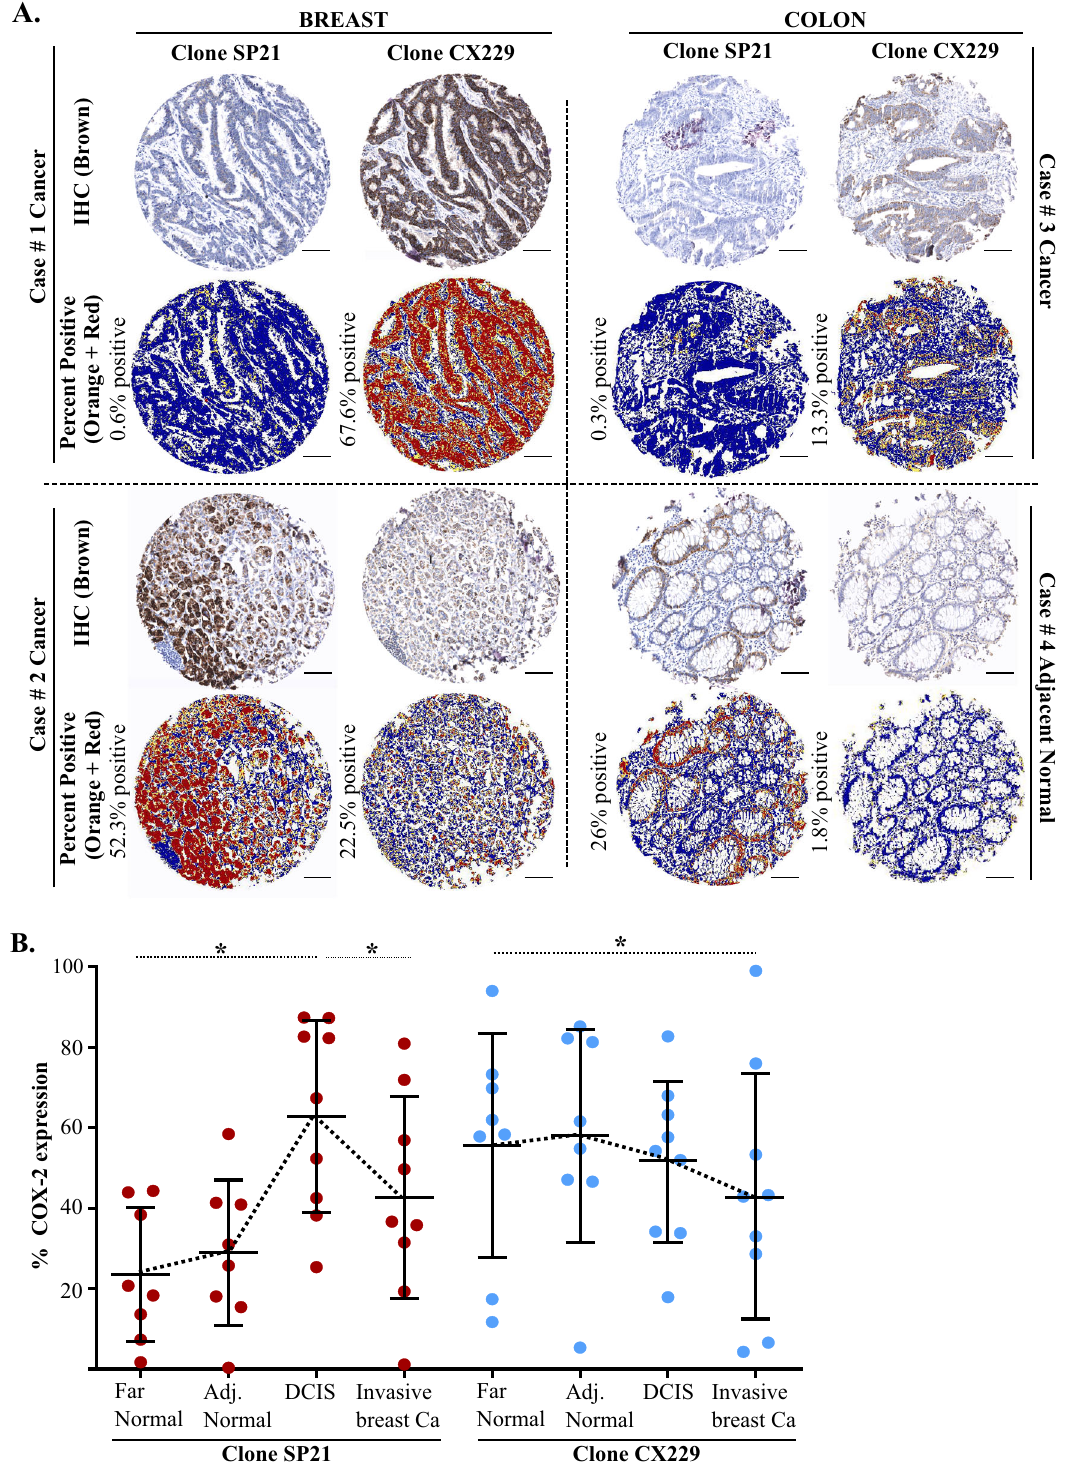
Fig. 3 Two α COX2 clones show differential pattern of staining. A TMA cores from breast and colon cancer cases show preferential CX229 (cases #1 and #3) or preferential SP21 staining (cases #2 and #4). Algorithmic analysis for each TMA core shows COX2 positive signal (orange and red) compared to negatively stained tissue (blue). B Sequential sections of individual cases were stained for SP21 (red) and CX229 (blue), and evaluated for COX2 expression in far and adjacent normal, DCIS, and invasive breast cancer tissue ( n = 9). SP21 shows highest expression in the DCIS lesions. Clone CX229 shows highest COX2 expression in normal far and adjacent breast epithelium, with decreased COX2 expression in invasive cancer ( *P values: ≤ 0.05). Scale bar for all images is 100